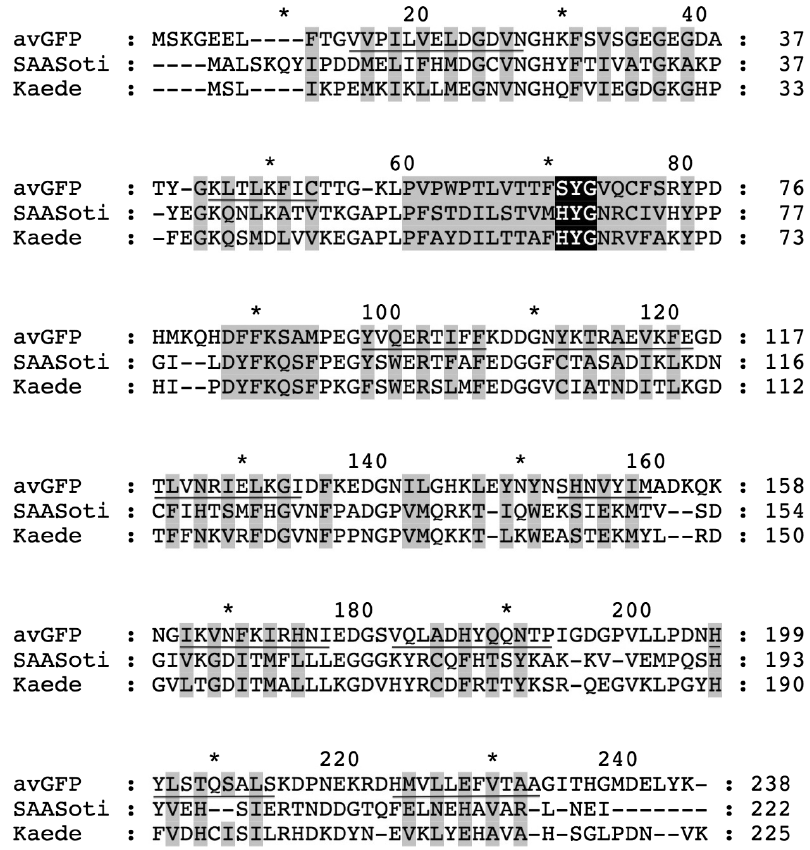
Fig. 3. Amino acid sequence (single-letter code) alignment of the novel protein SAASoti with Kaede and avGFP ( A. victoria GFP). 27 The numbering is based on A. victoria GFP. In the sequence of avGFP sheet-forming regions are underlined. Residues whose side chains form the interior of the (cid:2) -can 3 are shaded. Residues responsible for chromophore synthesis are indicated by black